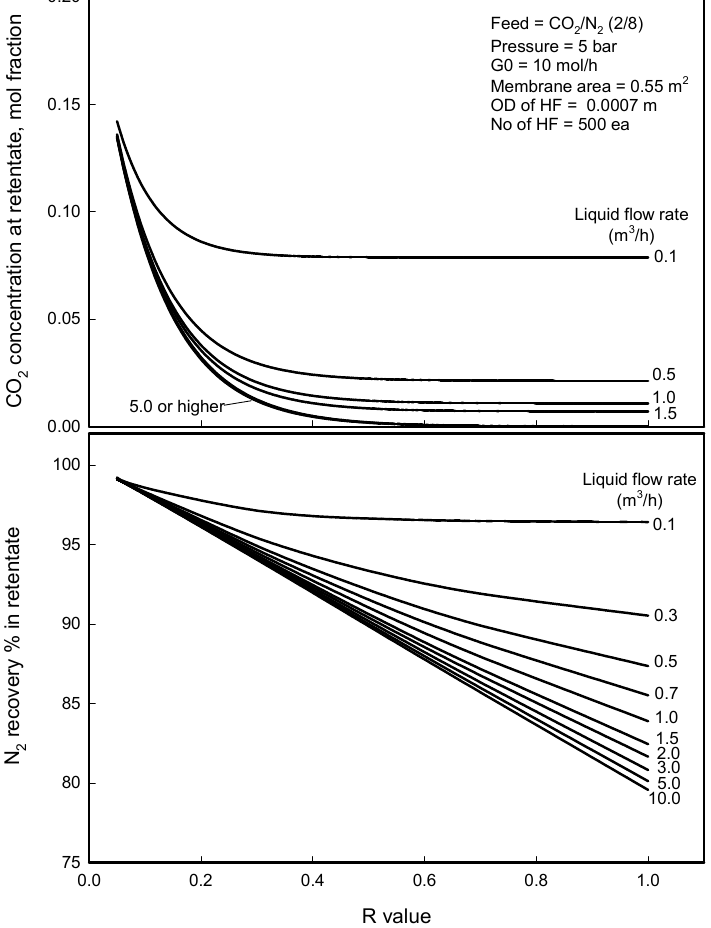
Figure 14. CO 2 concentration and N 2 recovery percent of retentate stream with R-value in the gassing of N 2 /CO 2 mixture in membrane contactor process.